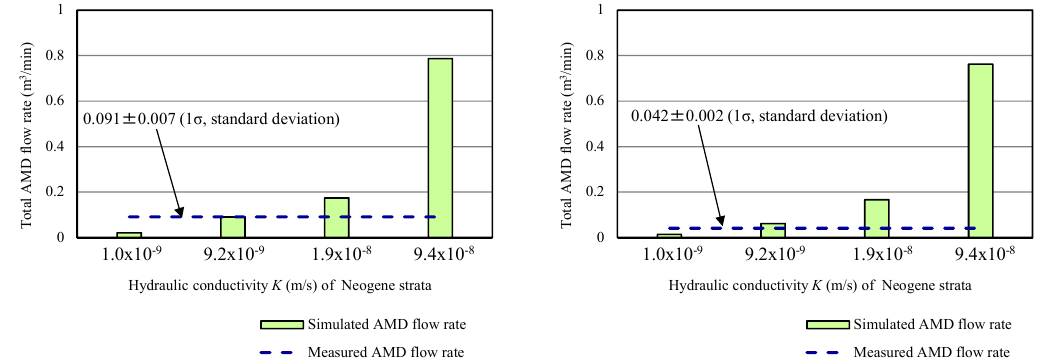
Figure 5. Comparison between the simulated and measured acid mine drainage (AMD) flow rate of days with high ( right ) and little ( left ) rainfall.